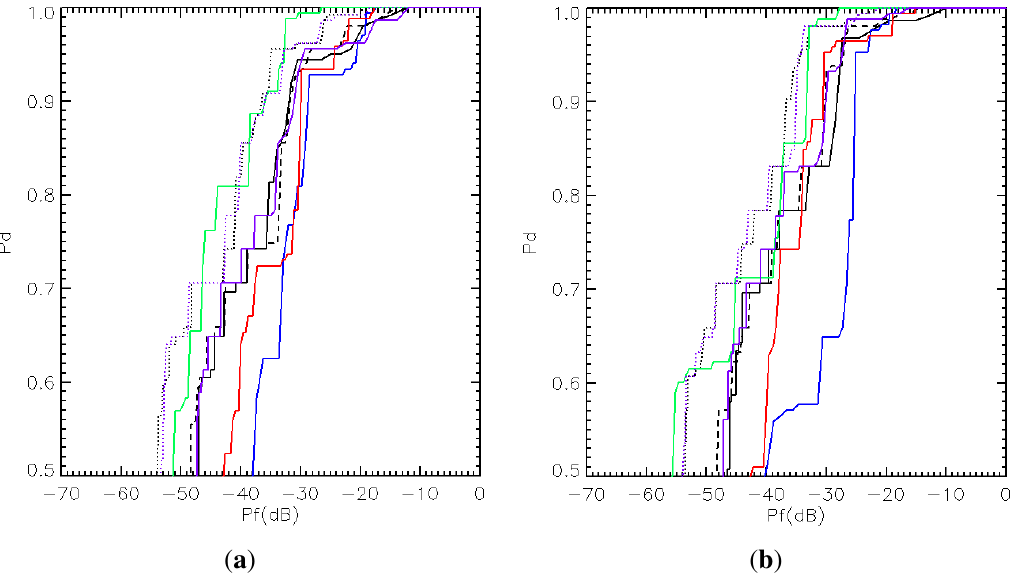
Figure 8. Detector ROC curves for sub-look analysis in the range. TerraSAR-X HH/VV data. Boxcar filter: 7 × 3 (range × azimuth) pixels. ( a ) VV channel; ( b ) HH channel. Vessels analyzed: 49; pixels used for P : ∼ 10 − 8 . Black: sub-look correlation (solid: filtered with f no overlap; dashed: filtered 30% overlap); blue: sub-look coherence; green: GLRT; violet: intensity (dotted: no average; solid: averaged); red: sub-look